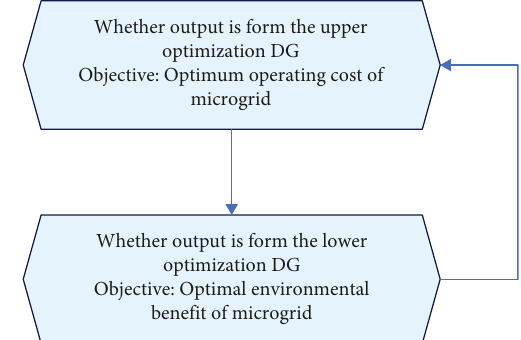
Figure 1: The relationship between the two main bodies of double- level economic dispatch in the